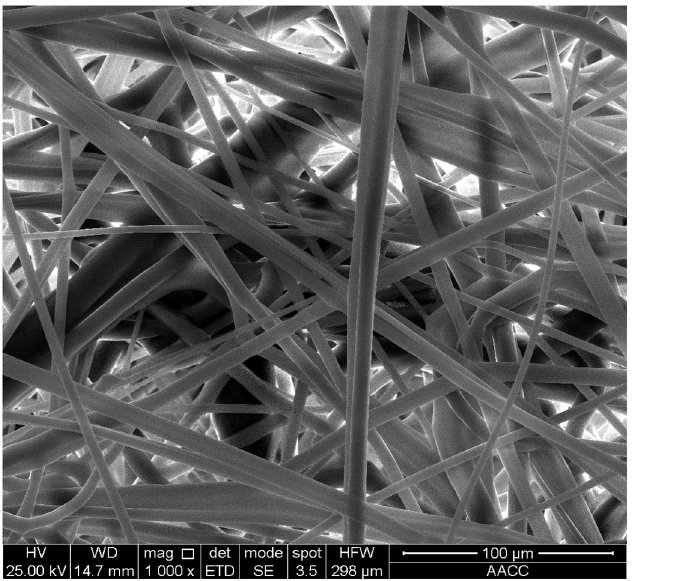
Fig 1. SEM image of filter media at the magnification of